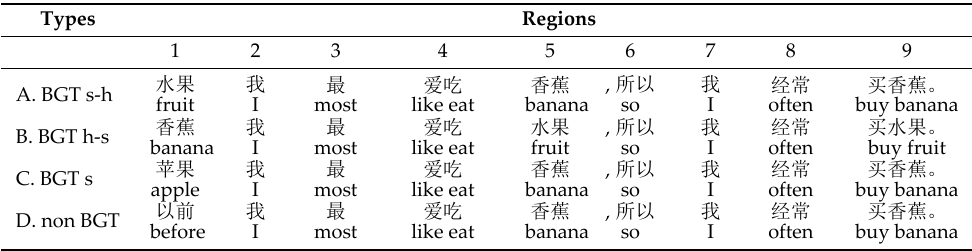
Table 2. Sample set of experimental sentence